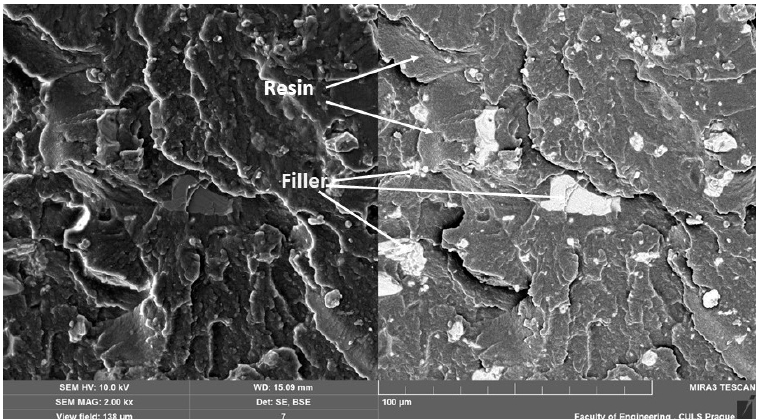
Figure 14. SEM images of fracture surface with filler CaCO 3 calcium carbonate, mixing speed— 2500 rpm (MAG 2.00 k×). SE figure is shown on the left and the BSE on the right.